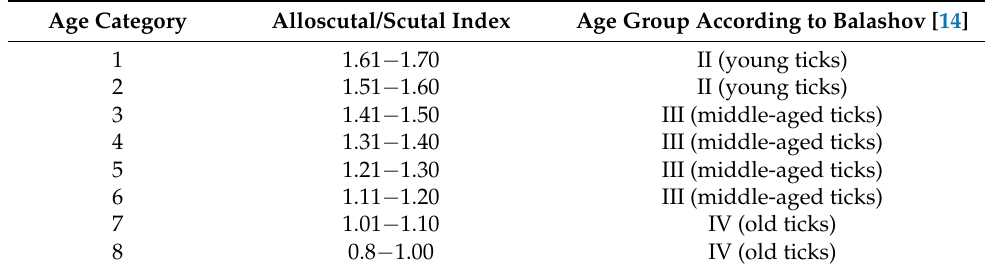
Table 1. Tick morphometric age categories used in the current study. Age